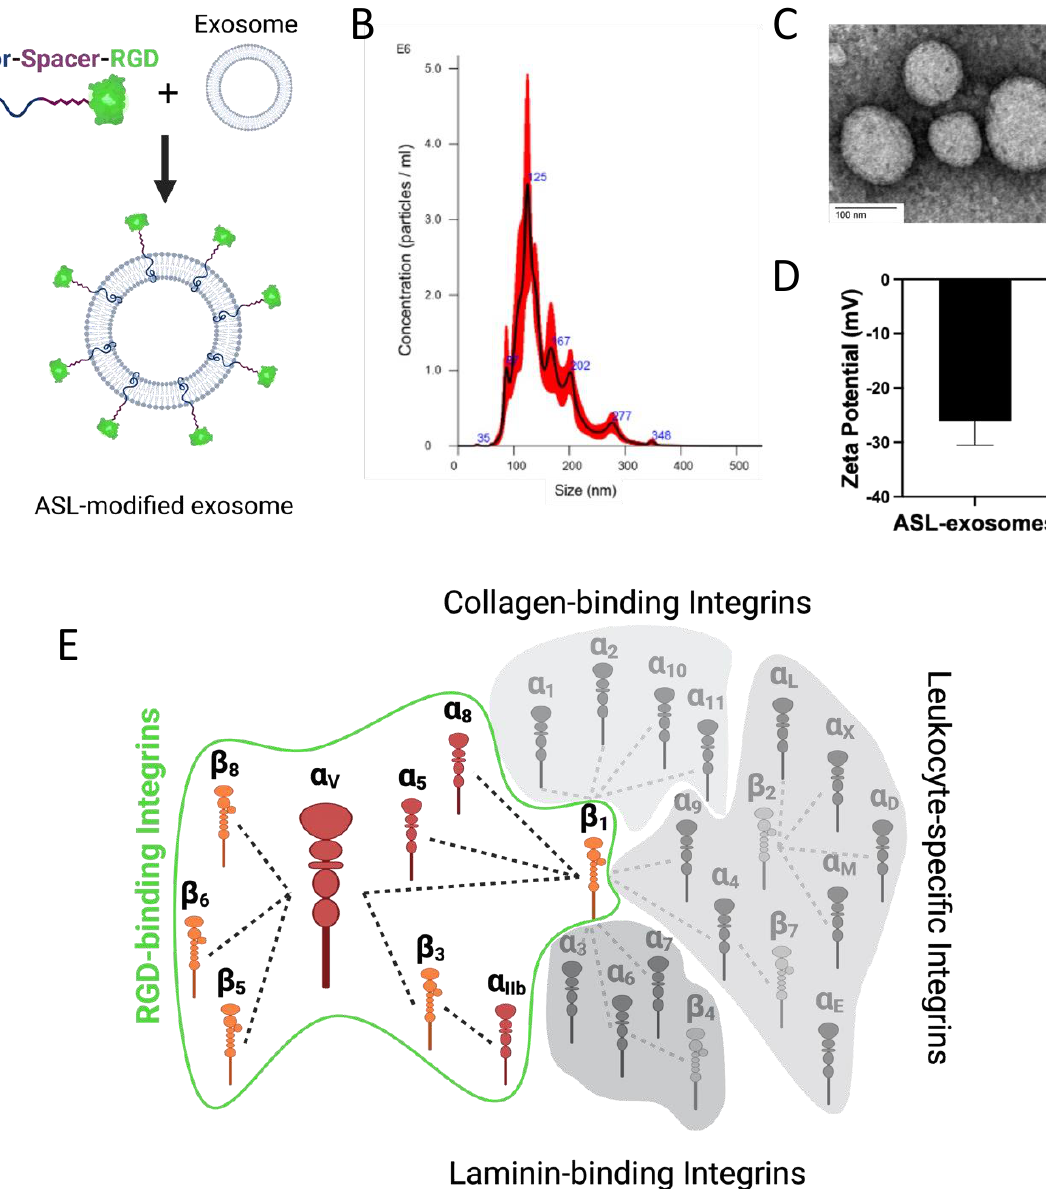
Figure 3. Engineering of Anchor, Spacer, and RGD Ligand (ASL)-modified exosomes, ASL exosomes. Retinal multicell-derived exosomes were engineered with ASL modification composed of a membrane Anchor (BODIPY), Spacer (PEG), and targeting Ligand, and cyclic Arg-Gly-Asp (RGD) peptide ( A ). The size and morphology of ASL exosomes were confirmed by NTA (mean size: 152 nm) ( B ). RGD is one of the major binding ligands for integrin families including α 5 β 1 , α 8 β 1 , α V β 1 , α V β 3 , α V β 5 , α V β 6 , α V β 8 , and α IIb β 3 ( C ). Zeta potential of exosomes was measured (D). Major integrin binding ligands (E).